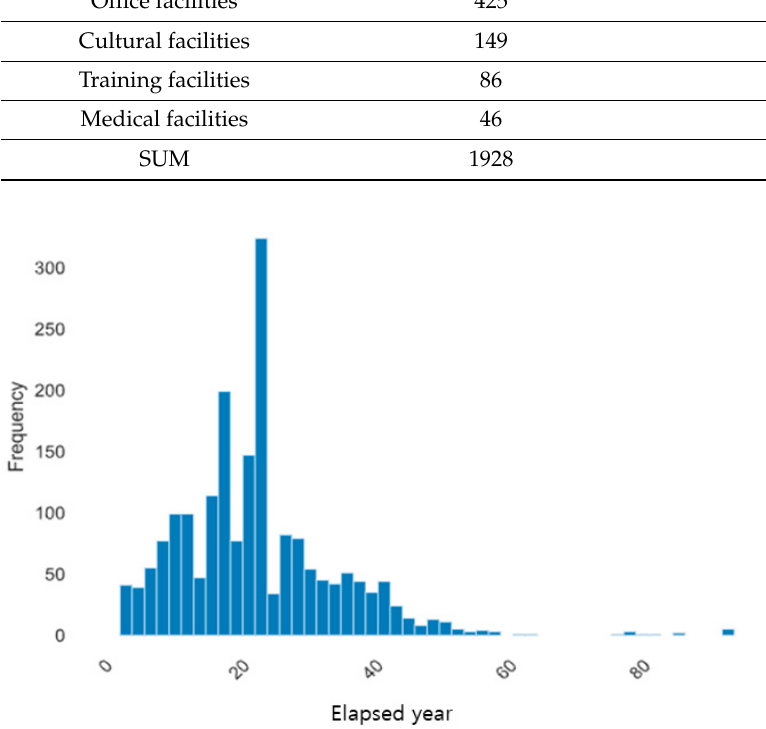
Figure 5. Histogram of the number of buildings according to the year of public buildings.